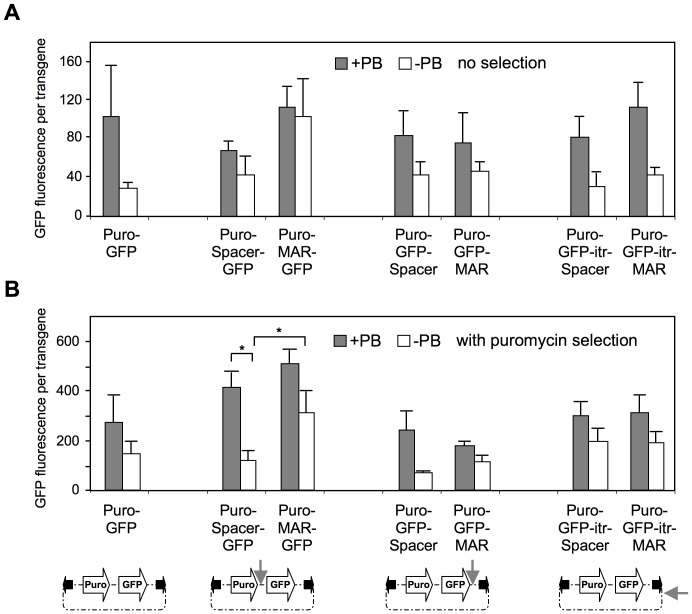
Effect of MAR on transposon copy number.The copy number of integrated GFP was determined using qPCR as described in supplementary. Fig S4, using unselected puromycin-resistant cells generated as described in the legends of Figure 2. The mean GFP fluorescence was divided by the number of integrated GFP transgene copies, to estimate the average expression per integrated GFP copy in unselected (A) and puromycin-resistant (B) CHO cells. Values represent the means ± SEM (n = 3). *P<0.05.